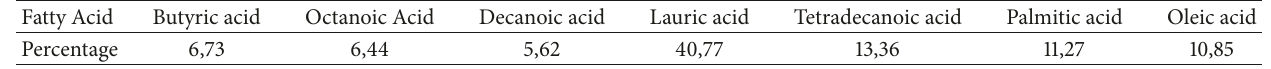
Table 1: Fatty acid composition of coconut oil.